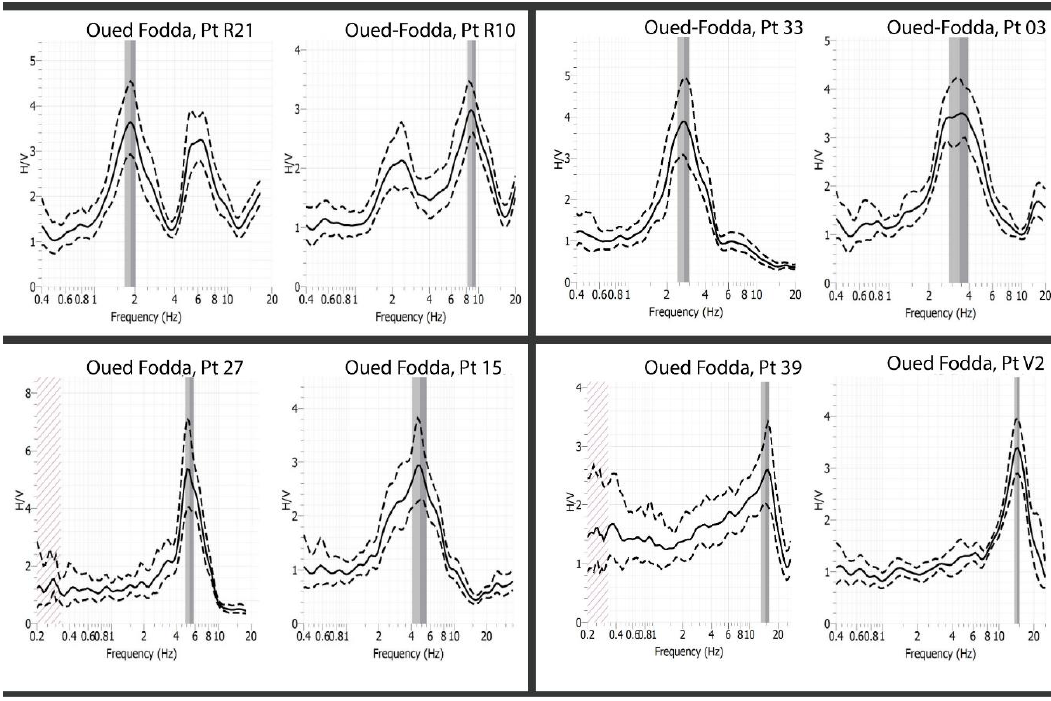
Figure 5. Some examples of the obtained HVSR curves. The gray vertical bands show the fundamental frequency peaks with its standard deviation. frequency peaks with its standard